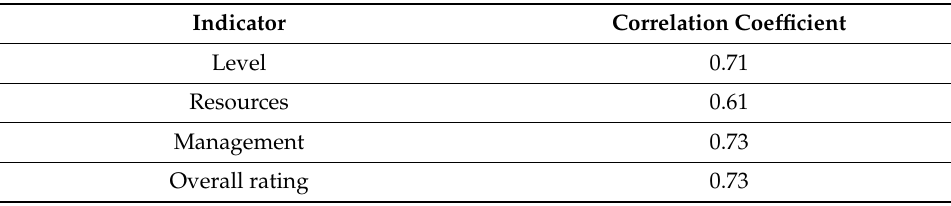
Table 5. The link between the tasks mismatch and the answers’ inconsistency.